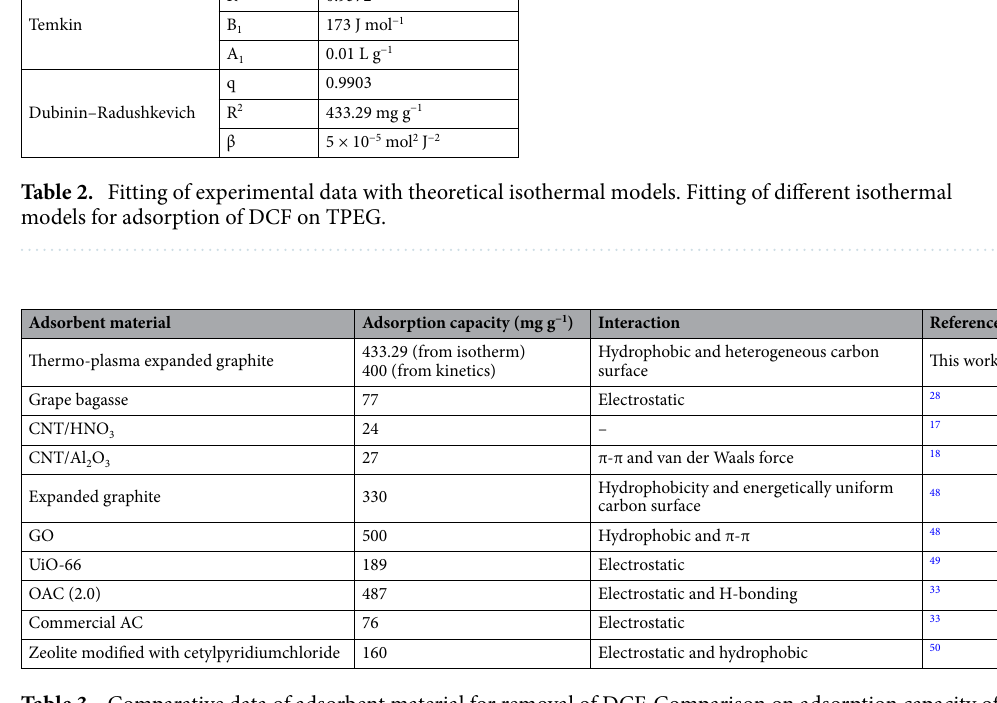
Table 3. Comparative data of adsorbent material for removal of DCF. Comparison on adsorption capacity of DCF on different adsorbent material.